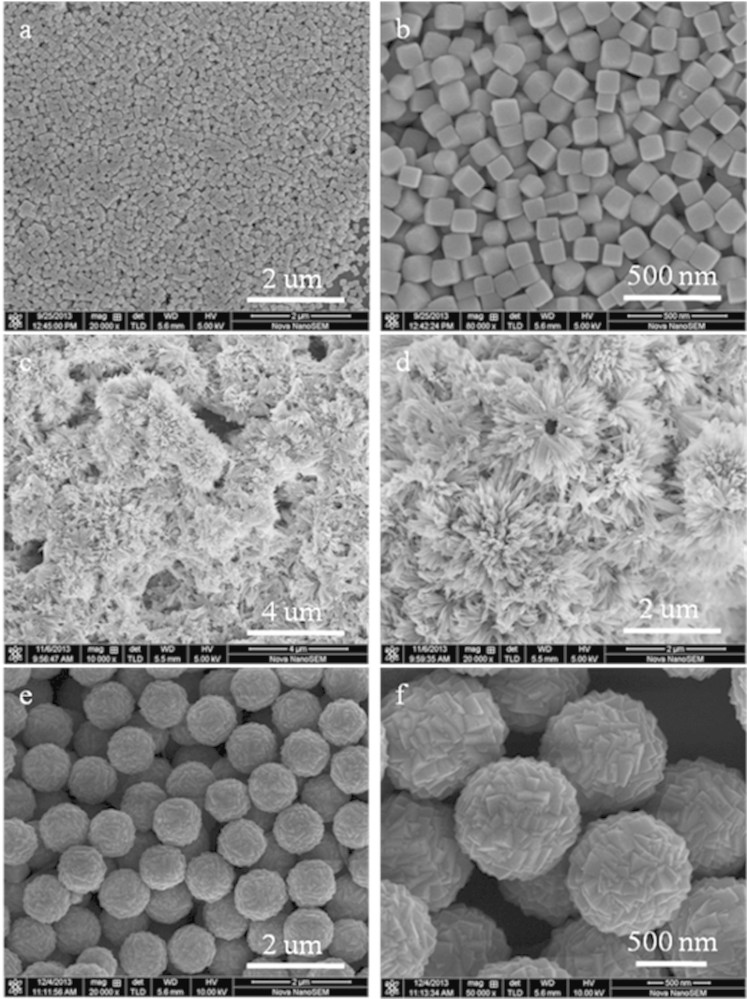
SEM images of the Cu2O prepared using different copper sources: (a and b) Cu(acac)2; (c and d) Cu(OH)2; (e and f) Cu(Ac)2·H2O.